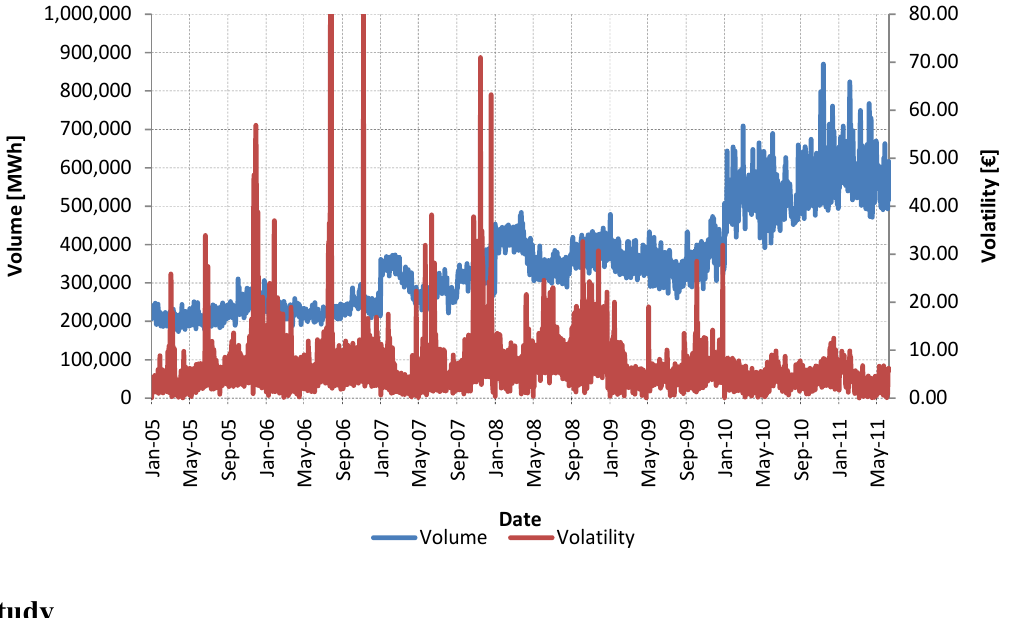
Figure 8. Volatility fluctuations and traded volume show that volatility jumps were more severe on lower levels of EEX spot market